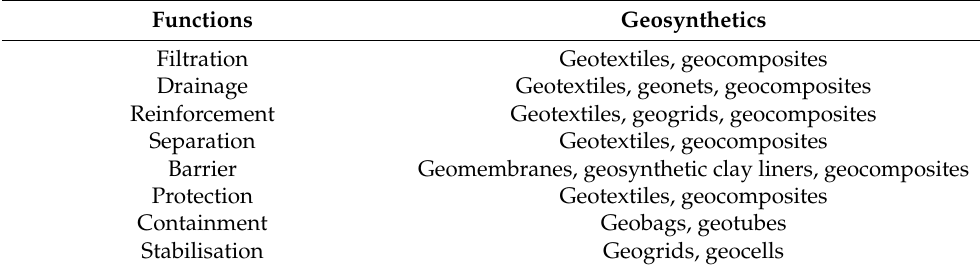
Table 3. Geosynthetics and their primary